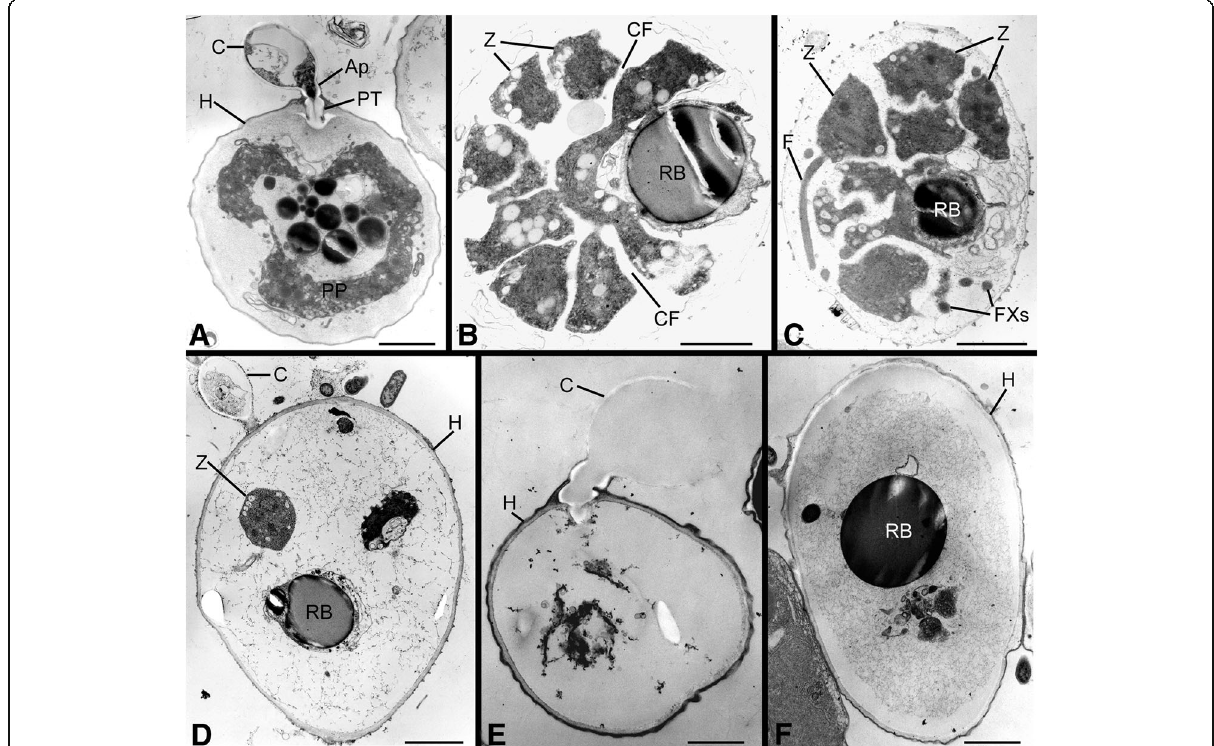
Fig. 3 Transmission electron micrographs of life stages representative of Aphelidiaceae . a Host cell (H) with a remnant cyst (C) attached to host via an appressorium (Ap) and infecting the host with a penetration tube (PT). Parasitoid plasmodium (PP) has engulfed much of the host cytoplasm. b Parasitoid plasmodium cleaved into multiple uninucleate cells (Z) delineated by cleavage furrows (CF); a residual body (RB) remains. c Cleaved zoospores, one with a flagellum (F); flagellar cross-sections (FXs) also visible. d An evacuated sporangium that retained a zoospore and the residual body. e An empty sporangium with ephemeral remnant of zoospore cyst. f An evacuated sporangium with a residual body. Figs. A, E= Am. occidentale (FD 01); Fig. B – D= Aph. desmodesmi (FD 104); Fig. F= Aph. protococcorum (FD 95) Bars: A – D, F=2 μ m, E=1 μ